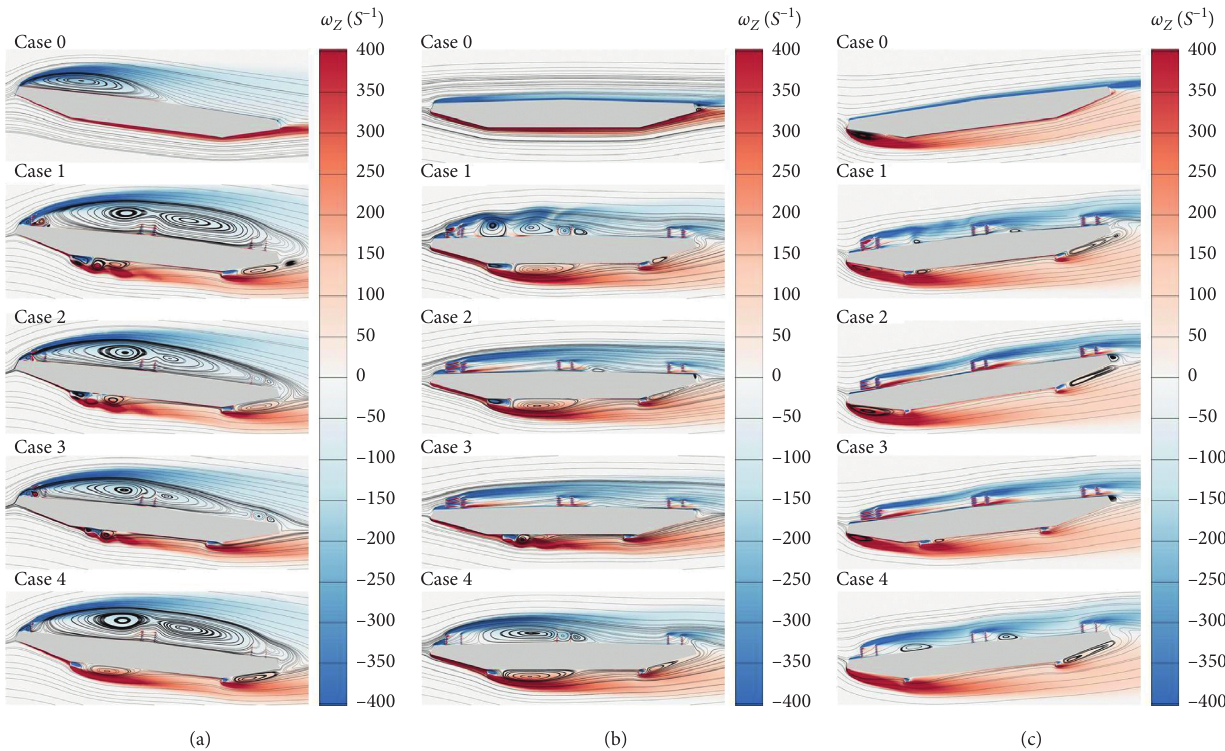
Figure 21: The flow field of different cases at different AoAs: (a) AoA � +5 ° ; (b) AoA � 0 ° ; (c) AoA � − 5 ° . Flow is from left to right; the flow streamlines are colored with vorticity values ( ω Z